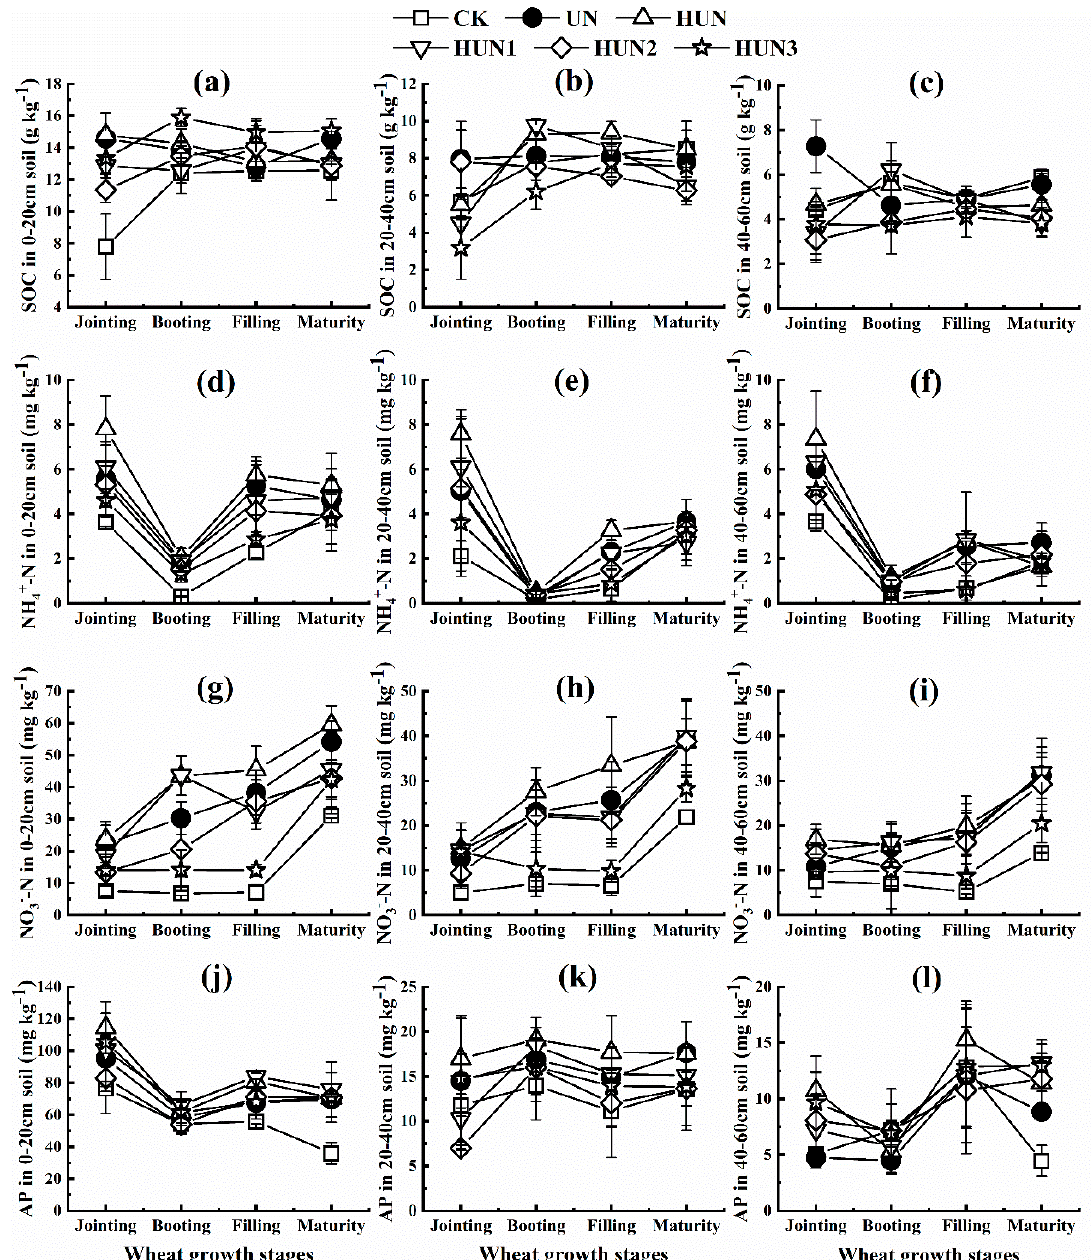
Figure 5. Effects of different treatments on soil nutrient content in wheat growth stages. The SOC contents of 0–20, 20–40 and 40–60 cm were shown as ( a – c ), respectively. The NH 4+ -N contents of 0–20, 20–40 and 40–60 cm were shown as ( d – f ), respectively. The NO 3 − -N contents of 0–20, 20–40 and 40–60 cm were shown as ( g – i ), respectively. The AP contents of 0–20, 20–40 and 40–60 cm were shown as ( j – l ), respectively. The vertical coordinate corresponding to the point is the average value. The length of the error bars is the standard deviation. SOC: soil organic carbon. NH 4+ - N: ammonium nitrogen. NO 3 − -N: nitrate nitrogen. AP: available phosphorus. CK: no